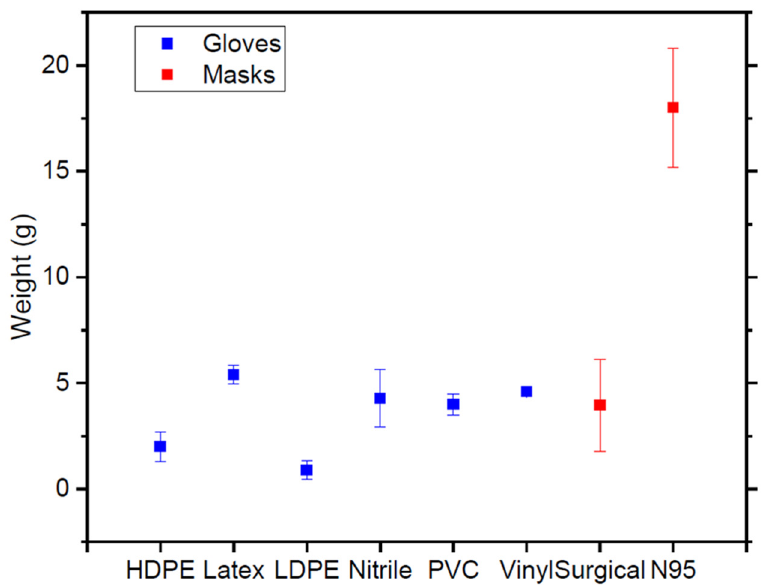
Figure 3. Weight for gloves of every different polymer and masks of different typologies (HDPE: High-Density Polyethylene, LDPE: Low-Density Polyethylene, PVC: Polyvinyl Chloride). Symbols indicate the average value, while bars indicate the standard